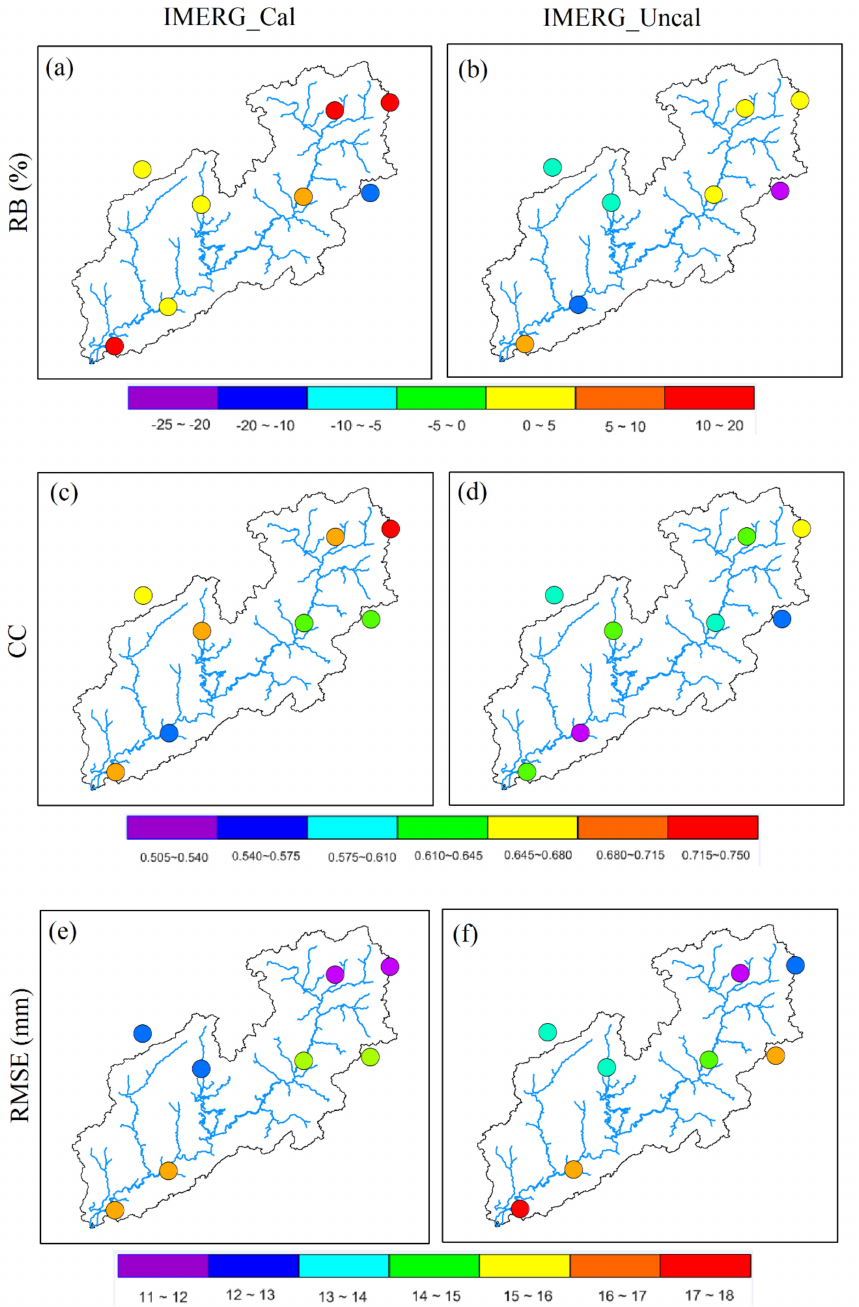
Figure 3. RB ( a , b ), CC ( c , d ), and RMSE ( e , f ) from IMERG, against gauge precipitation, from April 2014 to December